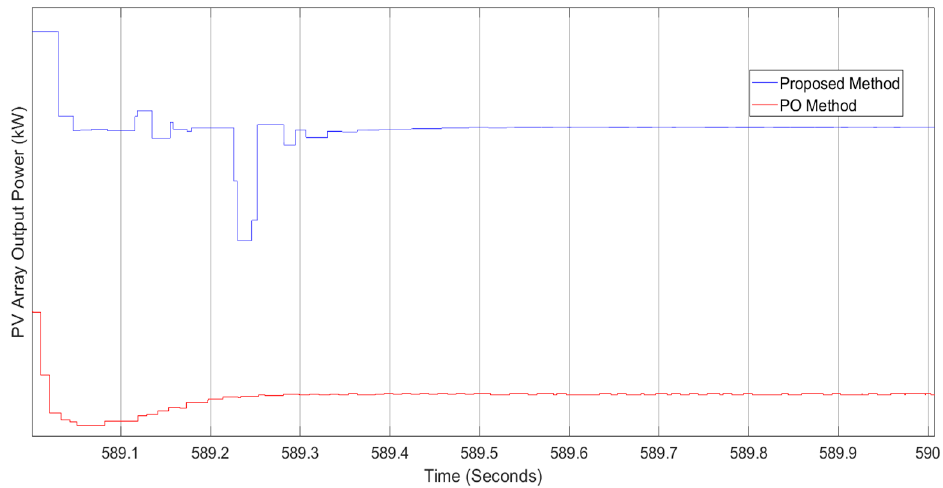
Figure 11. Sample of the output power of the proposed method and the PO method for a period (589 – 590) of time on a clear day.